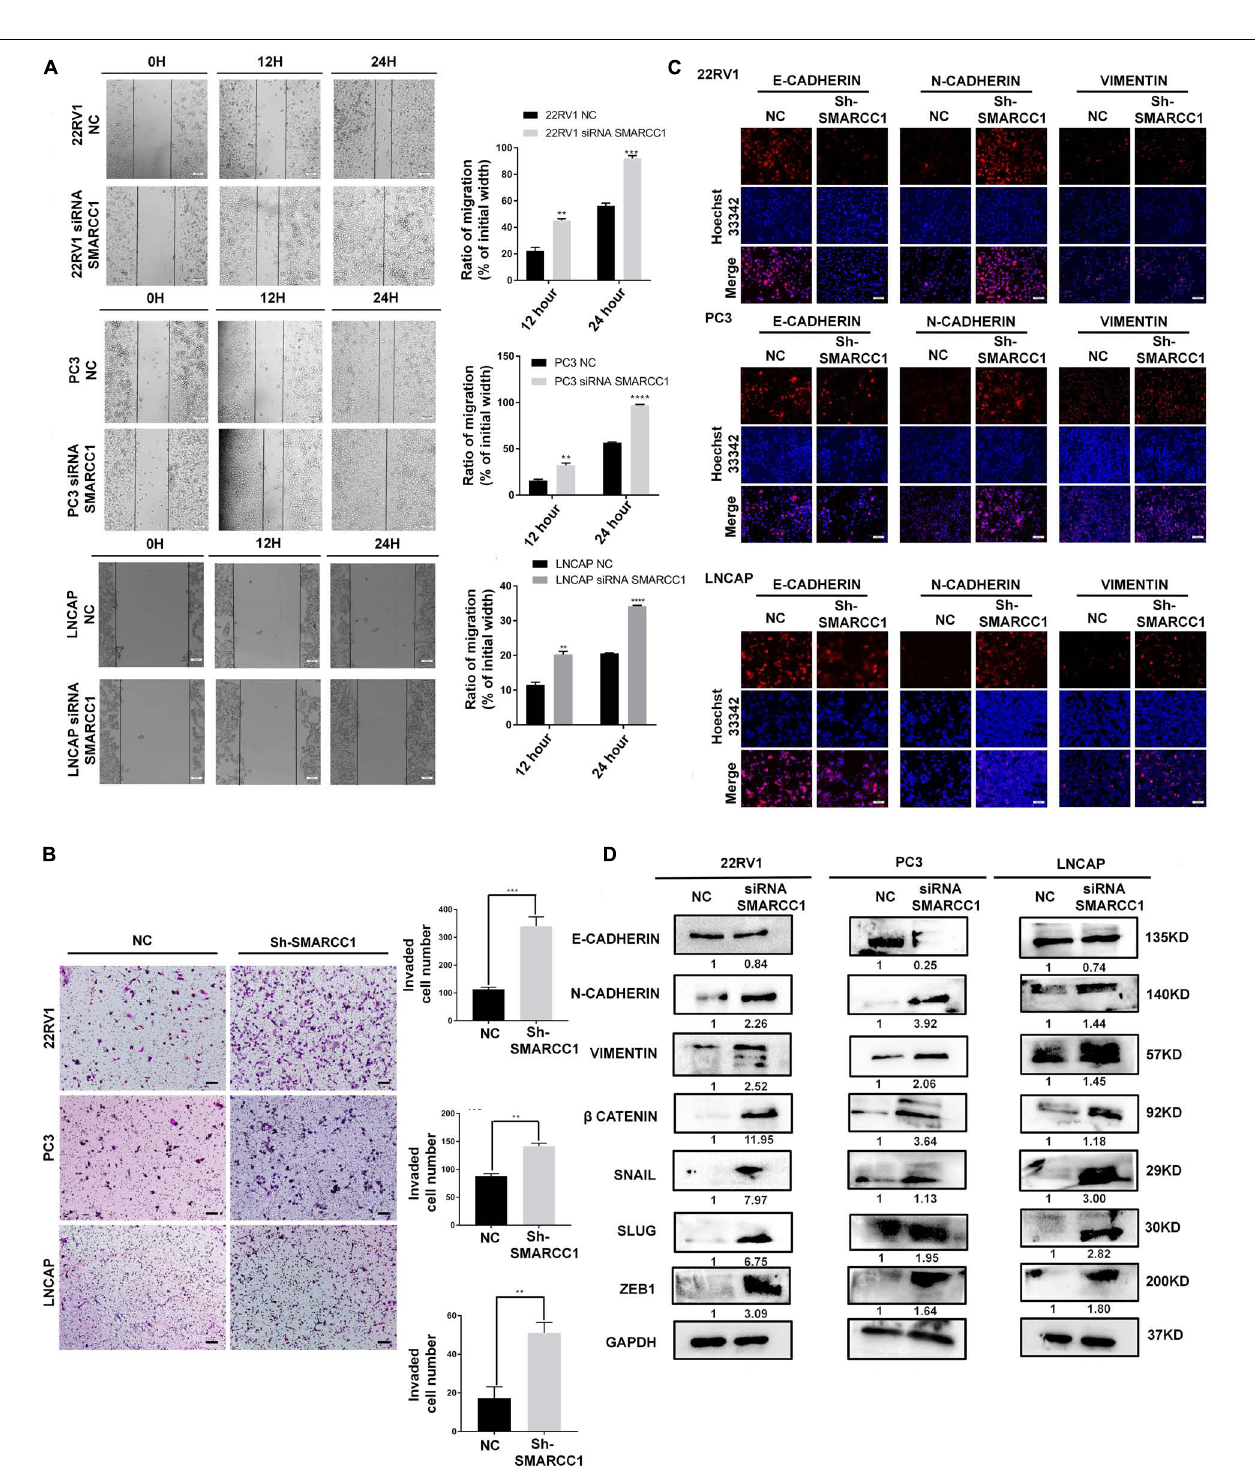
FIGURE 3 | SMARCC1 knockdown induced EMT, migration and metastasis of PCa. (A) Representative images showing in vitro wound area coverage by control and SMARCC1 -knockdown PCa cells (left panel; magnification 100 × ; Scale bar – 10 µ m) and percentage of migration (right panel). (B) Representative images showing migration of PCa cells in the Transwell assay (magnification 100 × ; Scale bar – 50 µ m) and percentage of migrating cells. (C) Representative immunofluorescence images showing E-cadherin, N-cadherin and vimentin expression in PCa cell lines (Scale bar: 100 µ m). (D) Expression of EMT markers and transcription factors involved in EMT in the indicated groups. Gray density values of proteins are indicated under the correspondent bands. All data are presented as mean ± SEM of at least three independent experiments. ** p < 0.01;*** p < 0.001; **** p < 0.0001.